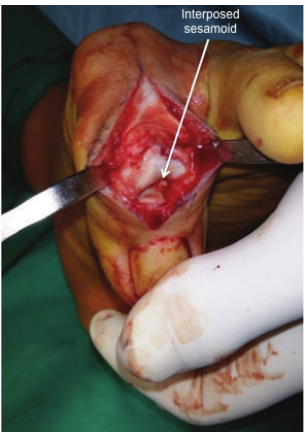
Figure 3: This is a clinical picture depicting open exploration of the IP joint of the left great toe with an interposed sesamoid rendering the dislocation irreducible.